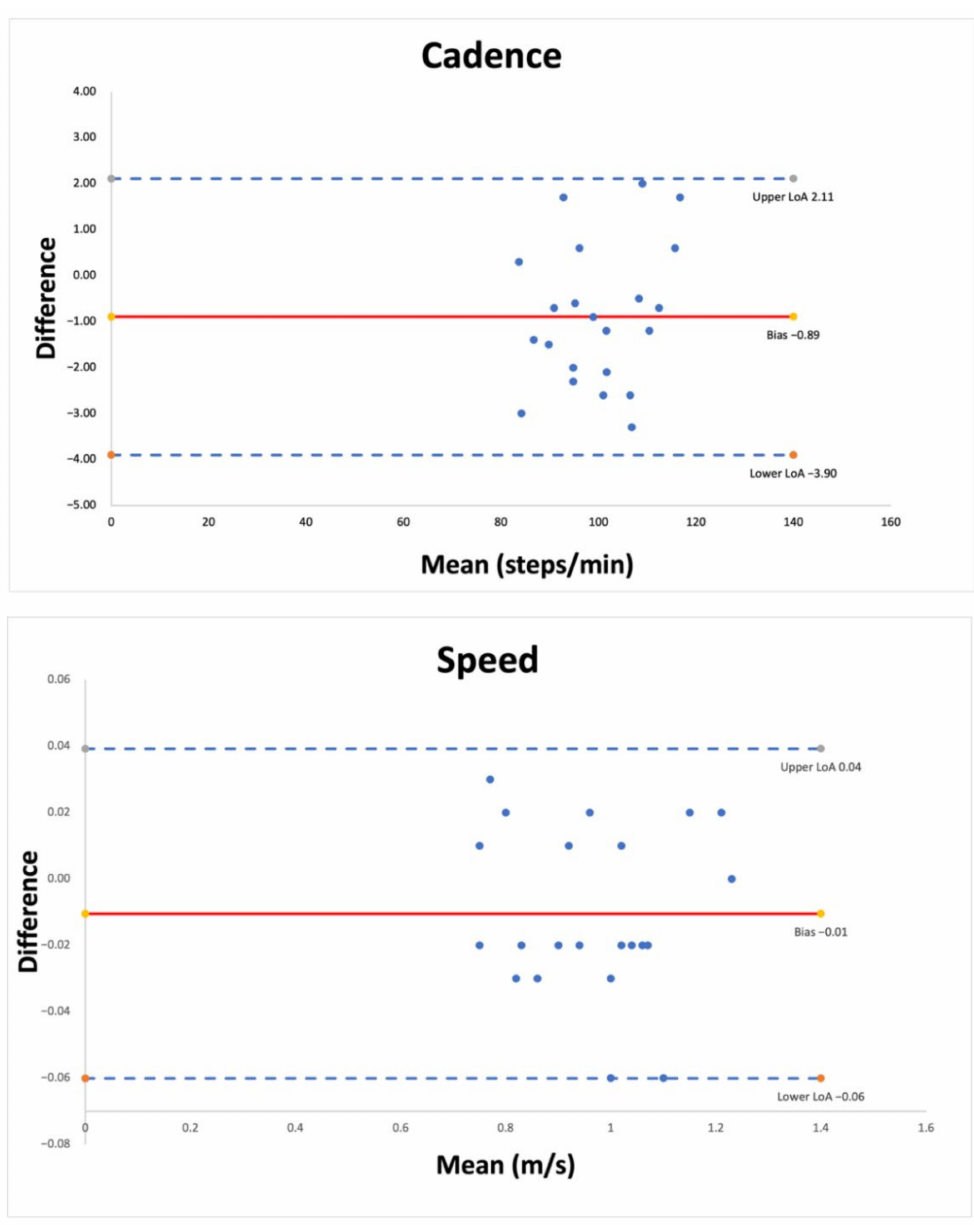
Figure 1. Bland-Altman plots for cadence and speed. Each graph presents the mean difference (solid line) and 1.96-fold standard deviation of difference (dashed line) indicating the limits of agreement between the